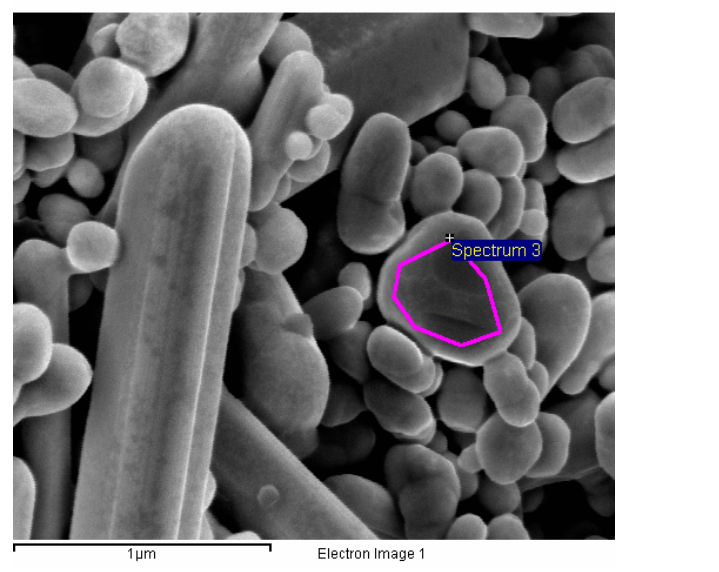
Figure 2 – Nanogold produced from an old jewellery scrap by the USP – method (Rudolf, et al, 2012,